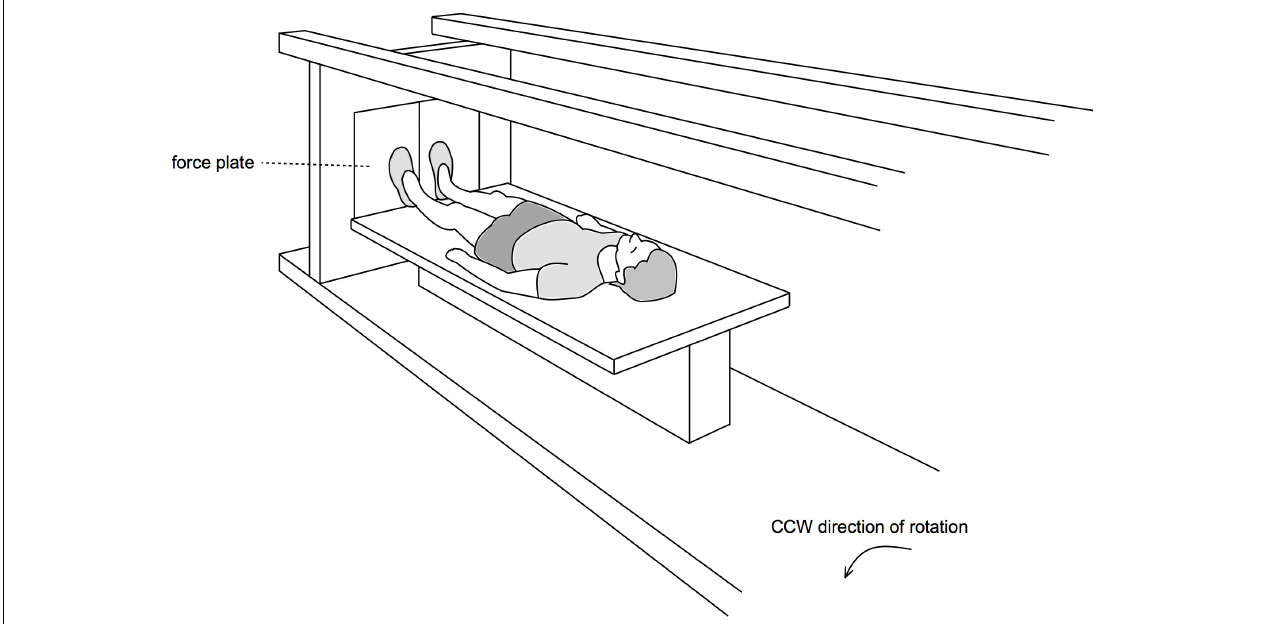
FIGURE 1 | Centrifuge. For the artificial gravity intervention, a short-arm human centrifuge was used. Participants lay supine on a thin mattress on one arm of the centrifuge, feet pointing outwards. Rotational speed and the participant’s position with respect to the center of rotation were individually adjusted to achieve an acceleration of 1g at the estimated center of mass and approximately 2 g at the